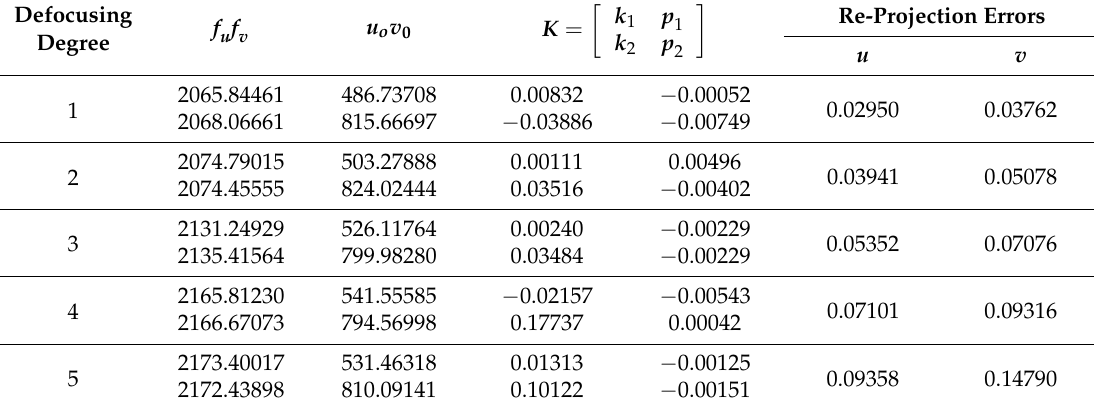
Table 2. Calibration results of a projector under different defocusing degrees when using the second